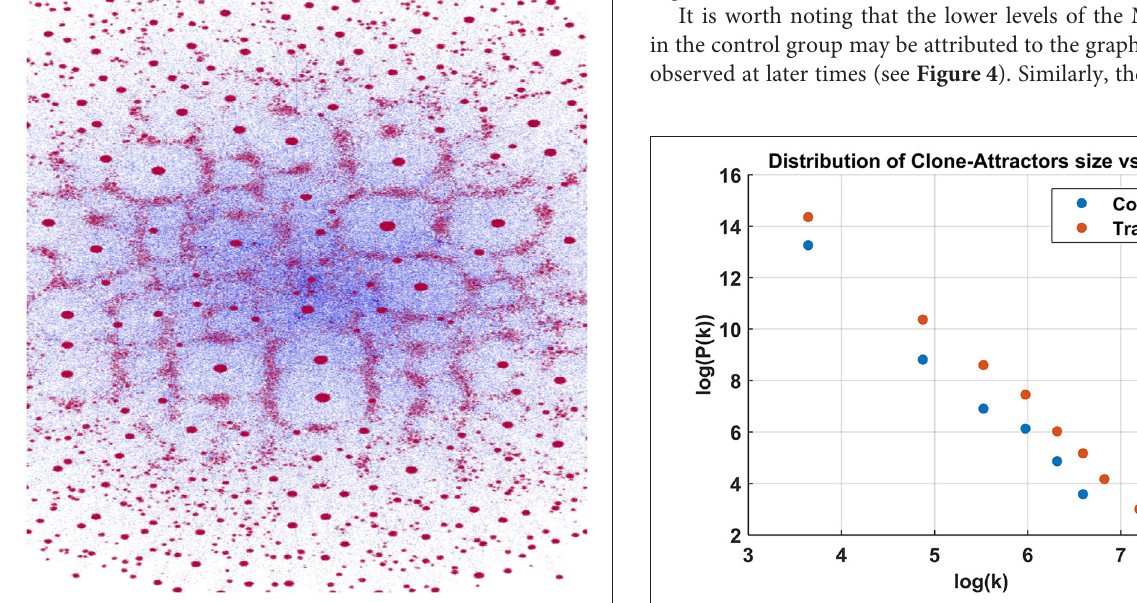
FIGURE 2 | Clone-Attractors network. Red dots represent nodes (CAs) of the graph (size proportional to the number of sequences in the CA), and blue lines are the edges (line width is inversely proportional to the distance.